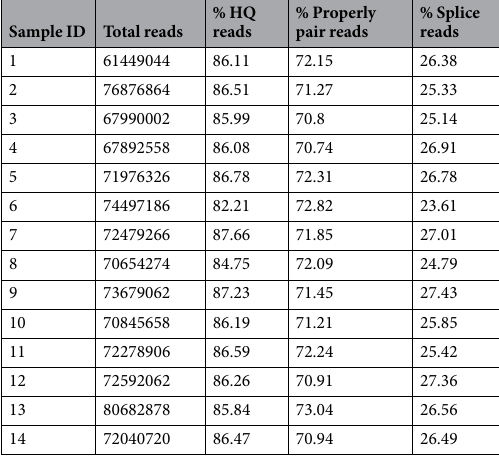
Table 1. Summary of RNAseq mapping data. HQ, high